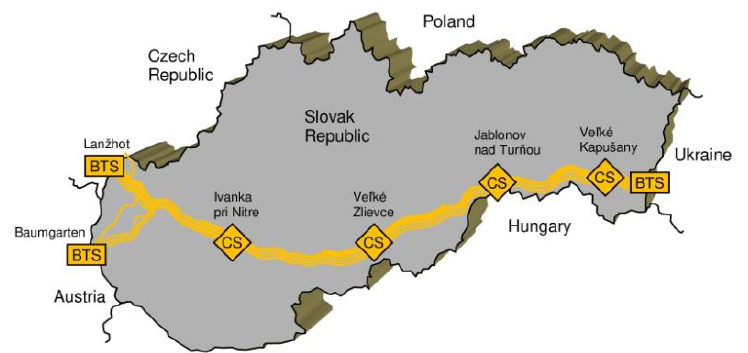
Figure 1. Scheme of the Eustream transport network on the territory of the Slovak Republic, where: CS—compressor station, BTS—border transfer station.